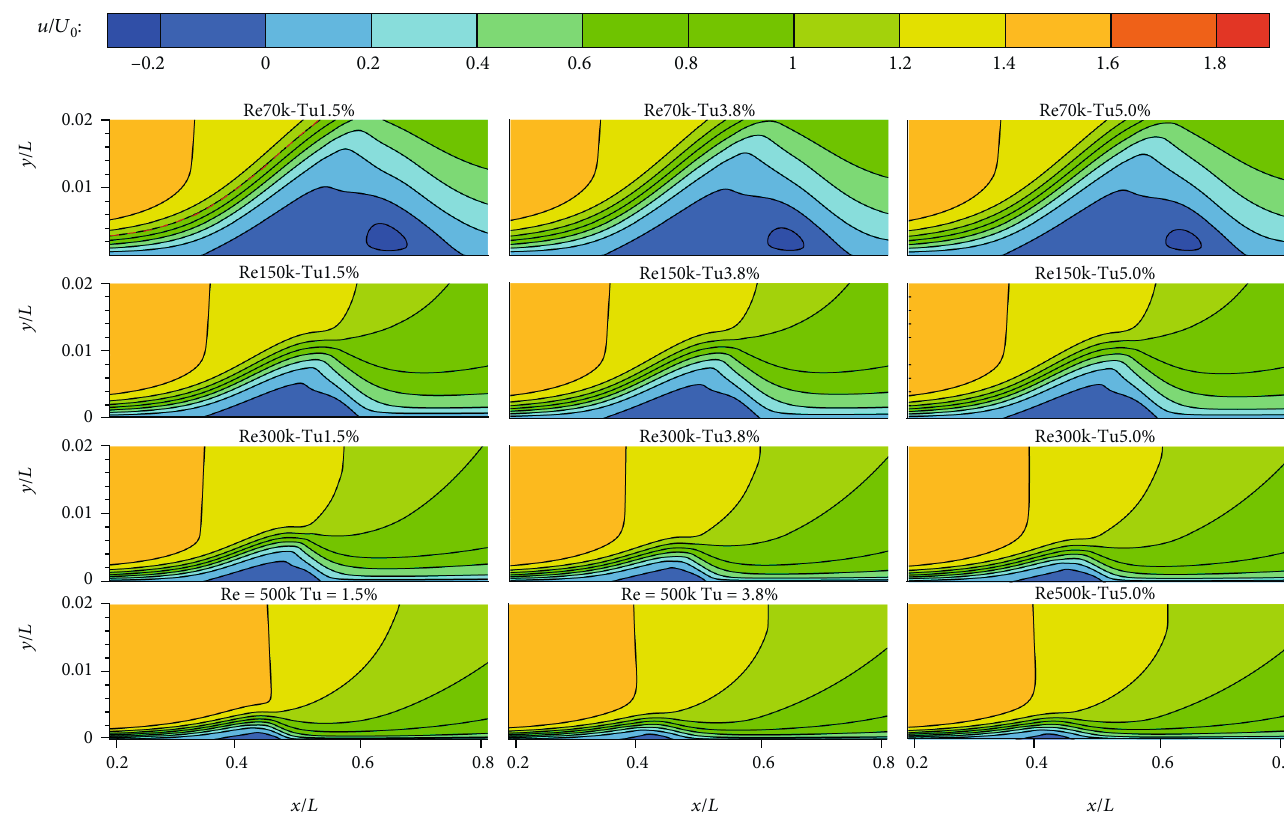
Figure 8: Comparison of normalized velocity component u / U